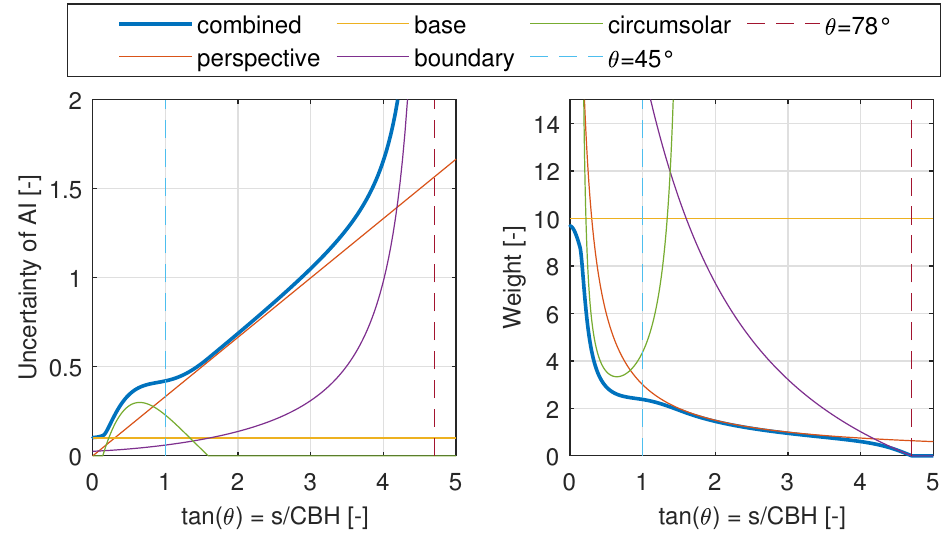
Figure A2. Left : Uncertainties present in ASI-based maps of attenuation index AI , by source and combined, are plotted over the grid cell’s distance ( s ) from the ASI normalized by local cloud base height (CBH). Right : Associated weights are plotted. s / CBH is equivalent to the tangent of the zenith angle (tan ( θ ) ), under which the ASI observes the grid cell of the map. The ASI images are evaluated up to a zenith angle θ = 78 ◦ . The circumsolar and consequently the combined weight are shown here for the direction which coincides with the sun’s azimuth angle on 5 June 2020